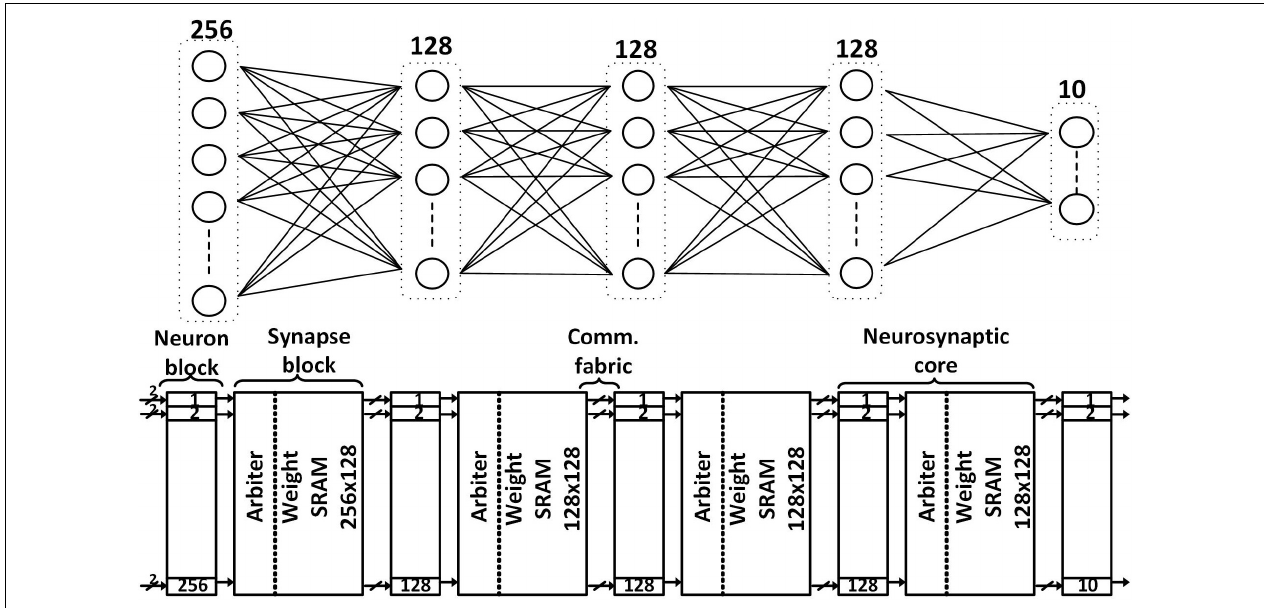
FIGURE 1 | The proposed SNN classifier architecture (bottom) with the maximum supported network size (top) for always-on functions like keyword